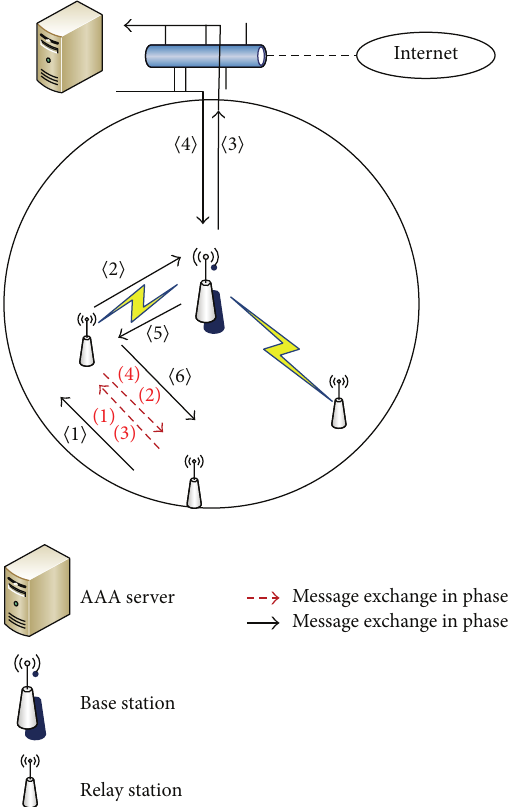
Figure 2: RS connects to MMR networks via an edge